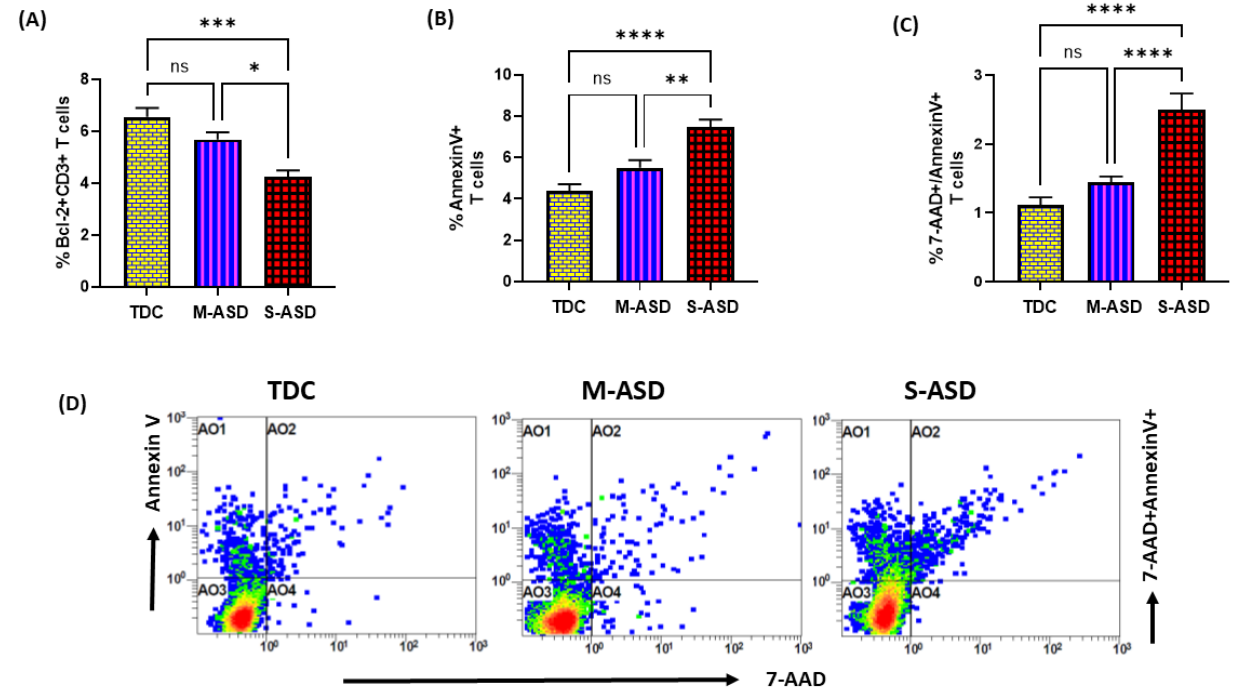
Figure 3. Bcl2 expression and apoptosis in the T cells of the ASD and TDC groups. ( A ) Bcl-2+ T cells, ( B ) annexin V+ T cells, ( C ) annexin V+/7-AAD+ T cells, and ( D ) Flow plot displaying the double- positive immunostaining of annexin V+/7-AAD+T. PBMCs were segregated from whole blood, fol- lowed by flow cytometry. The ASD group is further divided into mild – moderate (M-ASD) and se- vere (S-ASD). Values are shown as the mean ± SEM, n = 22 – 25/group. * p < 0.05; ** p < 0.01; *** p < 0.001; **** p < 0.0001.